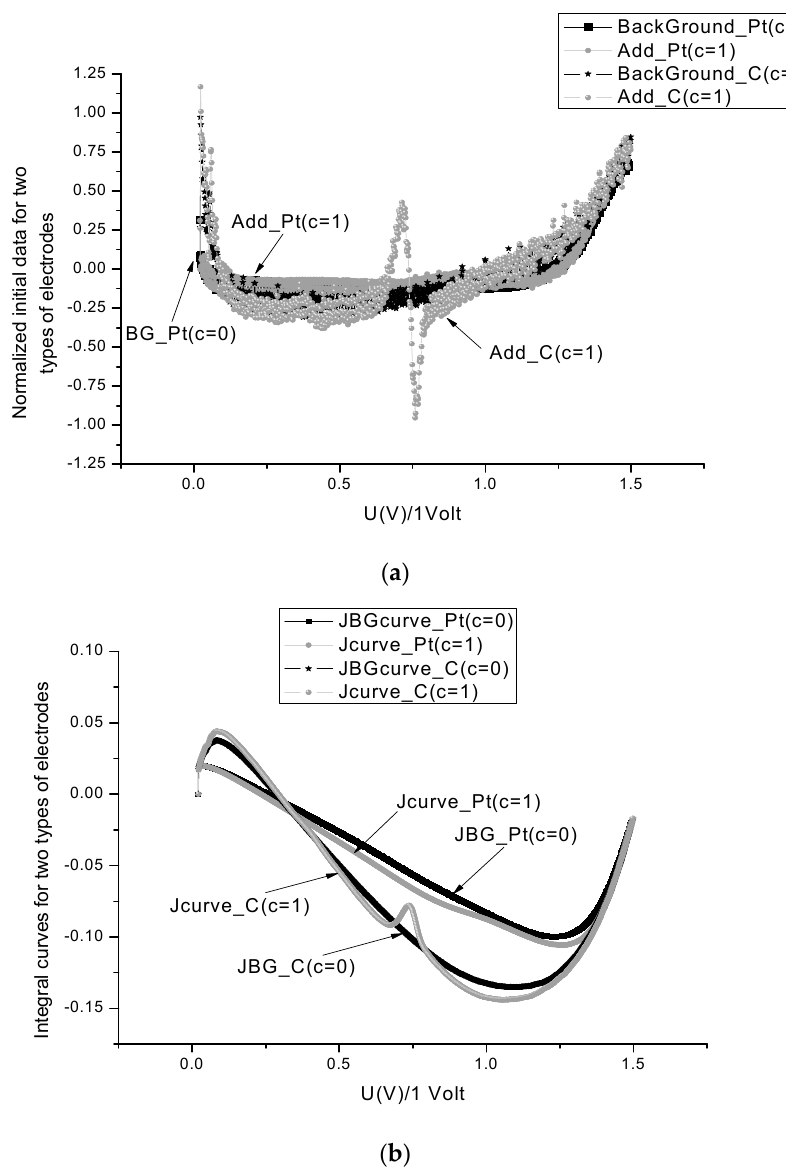
Figure 2. ( a ) VAG derivatives (d J /d U ) for two types of electrodes (Pt and C). Minimal concentration ( c = 1) corresponds to 6.54 × 10 − 5 mol ∙ L − 1 ; see Table 2 for details. ( b ) Normalized and integrated VAGs corresponding to the curves shown in the previous figure. These curves are more preferable for the detection of additives. The integration procedure was realized with the help of Equation (2), which eliminates the additional fluctuations and possible deviations evoked by the presence of an additive. Concentration c = 1 corresponds to the minimal concentration of 6.54 × 10 − 5 mol ∙ L − 1 ; see Table 2 for details.